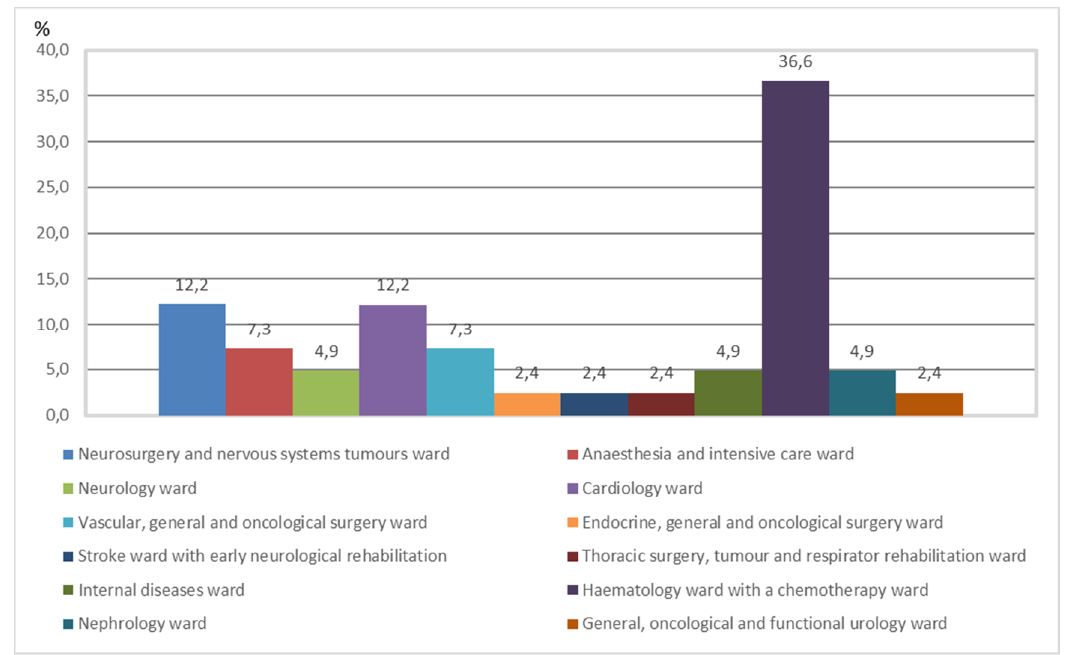
Figure 1. Occurrence of CDI infections in individual hospital wards (%).